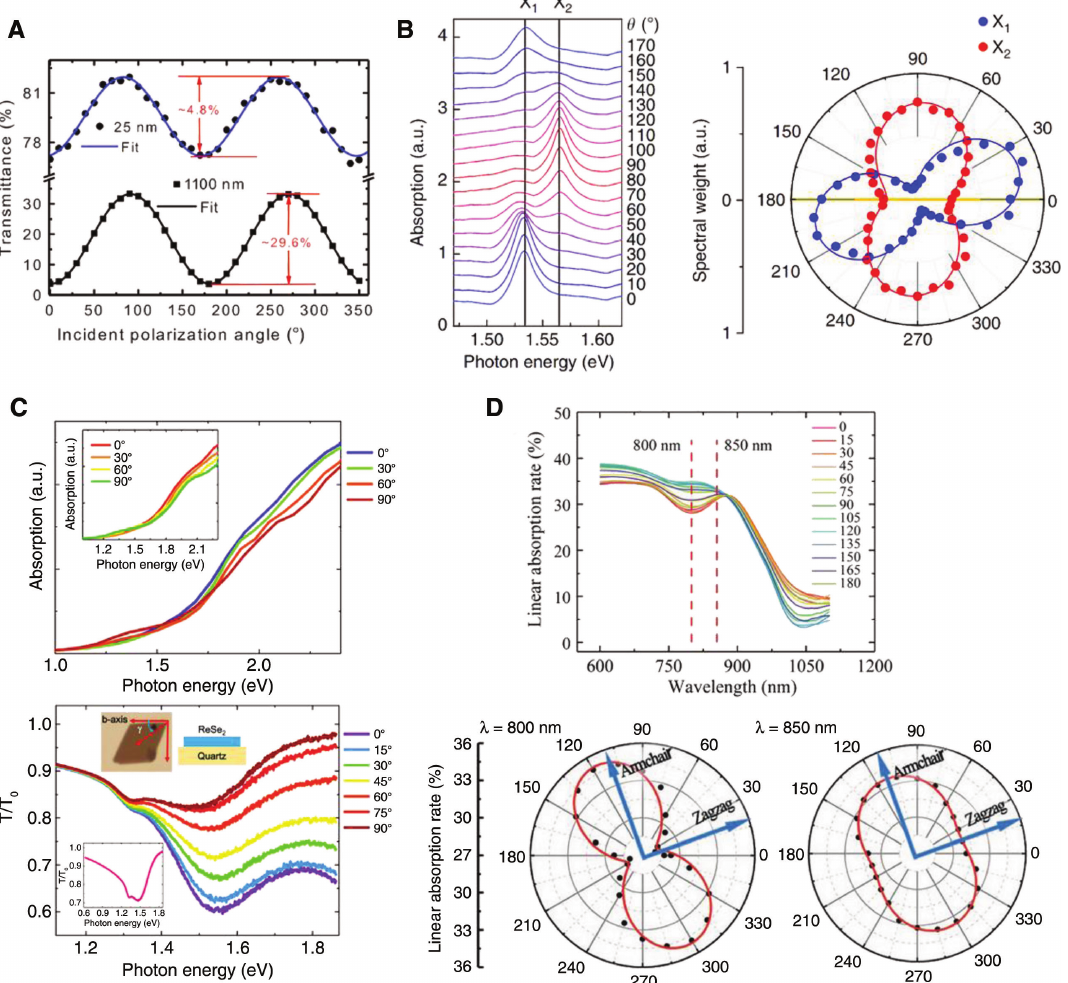
Figure 3: The angle-resolved linear absorption spectra of the anisotropic 2DLMs. (A) The transmittance of the BP films with the thickness of 25 nm (the blue curve) and 1100 nm (the black curve), showing the anisotropic absorption behaviors. Reproduced with permission from Li et al. [121]. (B) Left figure: the absorption spectra of seven- to eight-layer ReS ; 2 right: the corresponding spectral intensities of X (blue dots) and X (red dots) in polar plot. Reproduced with permission from Sim et al. 1 2 [101]. (C) The absorption spectra of bulk ReSe . Top figure: the theoretical calculation of angle-resolved optical absorption spectra of the 2 bulk ReSe (the insert shows the calculated optical absorption spectra of monolayer ReSe ); bottom figure: the measured polarization- 2 2 dependent optical absorption spectra of ReSe (the insert shows the experimental transmission spectra in a wider range with unpolarized 2 light). Reproduced with permission from Zhang et al. [102]. (D) Top figure: the polarization-dependent linear absorption spectra of SnSe flake sample; bottom figure: the polar plots of the linear absorption rate of SnSe flake sample at 800 and 850 nm, respectively. Reproduced with permission from Zhang et al.